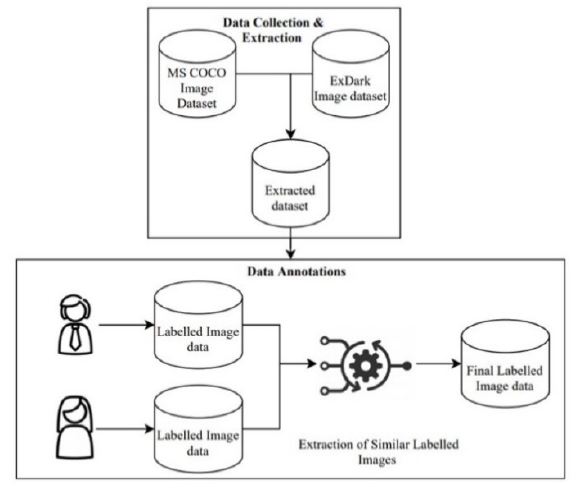
Figure 2. Image Dataset Development Protocol.